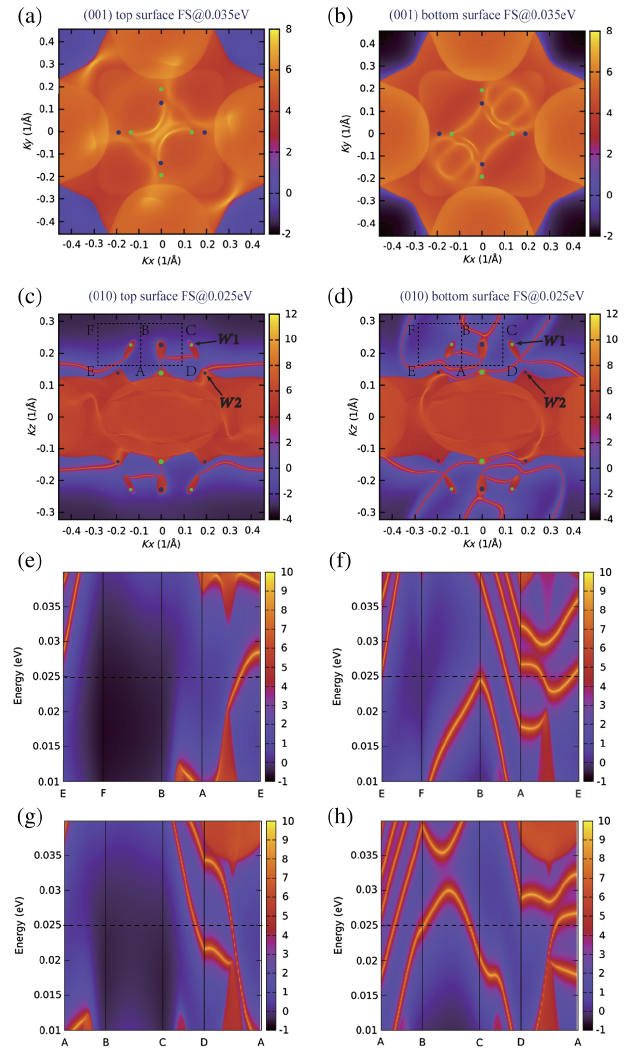
FIG. 5. Fermi surface on (a) top and (b) bottom (001) surfaces of the sample. All the dots represent two WPs with the same chirality projecting on top of each other. (c,d) Fermi surface on the top and bottom (010) surfaces, respectively. The small dots represent the single projected WP, and the large dots represent two WPs with the same chirality projecting on top of each other. Panels (e) and (g) are the surface states of the top surface along the closed paths of E-F-B-A-E and A-B-C-D-A, respectively. Panels (f) and (h) are the same as (e) and (g) but for the bottom surface.